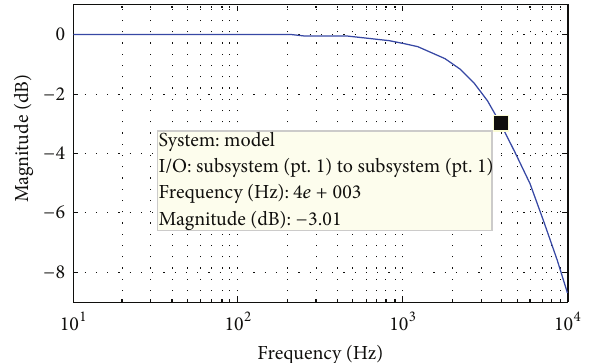
Figure 5: Bode diagram of current control loop.